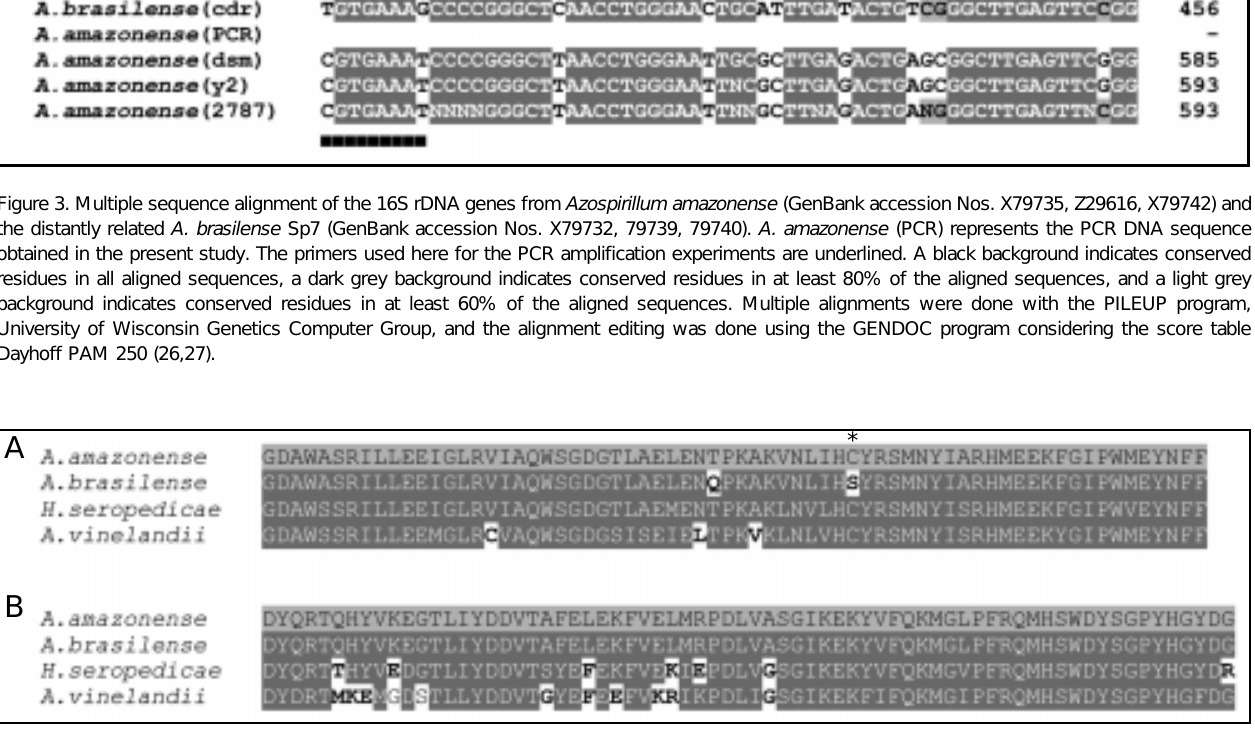
Figure 4. Azospirillum amazonense nifD protein partial sequence alignment with A. brasilense (GenBank accession No. M64344), Herbaspirillum seropedicae (GenBank accession No. Z54207) and A. vinelandii (GenBank accession No. M20568) NifD proteins. A grey background indicates similarity including the conserved amino acid substitutions while using the A. amazonense sequence as reference sequence. Amino acid-derived sequence from DNA sequencing obtained with primer nifD-up (A) and with primer nifD-do (B). The cysteine residue 275 is marked with an asterisk. Multiple alignments were done with the PILEUP program, University of Wisconsin Genetics Computer Group, and the alignment editing was done with the GENDOC program considering the Dayhoff PAM 250 score table (26,27).